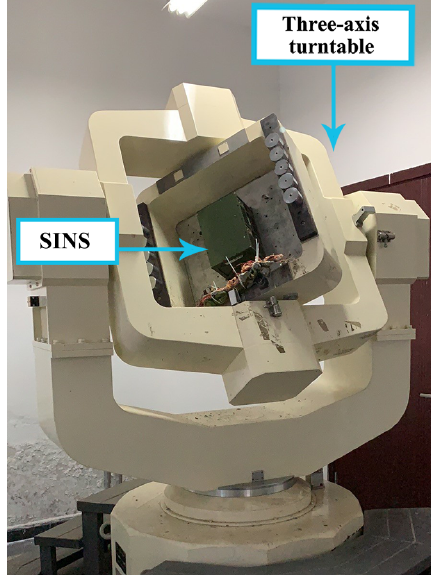
Figure 4. Calibration facilities. Table 3. Position RMSE results.